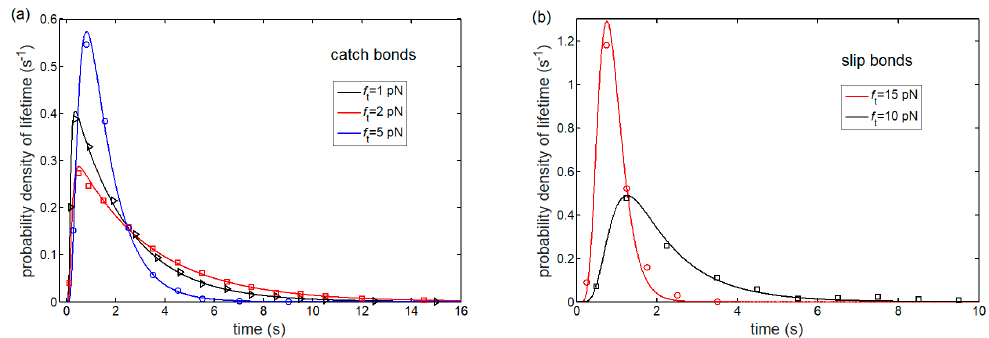
Figure 4. Probability density of lifetime of ( a ) catch-bond and ( b ) slip-bond clusters as a function time for N t = 10 and di ff erent interfacial forces (lines: theoretical predictions from Equation (5); symbols: Monte Carlo simulations).